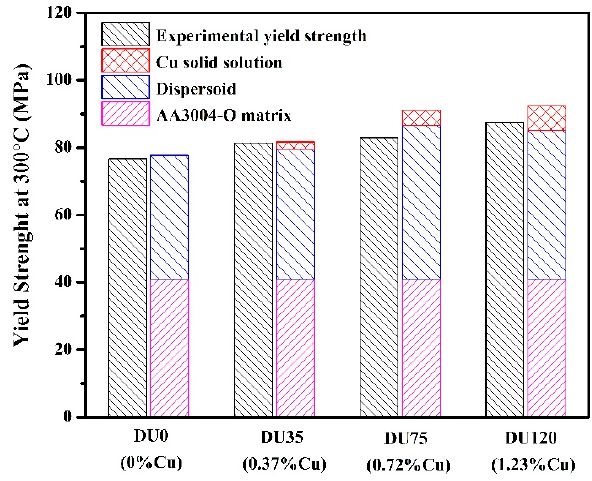
Figure 15. The comparison of the yield strength at 300 °C between calculated and experimentally measured ones.